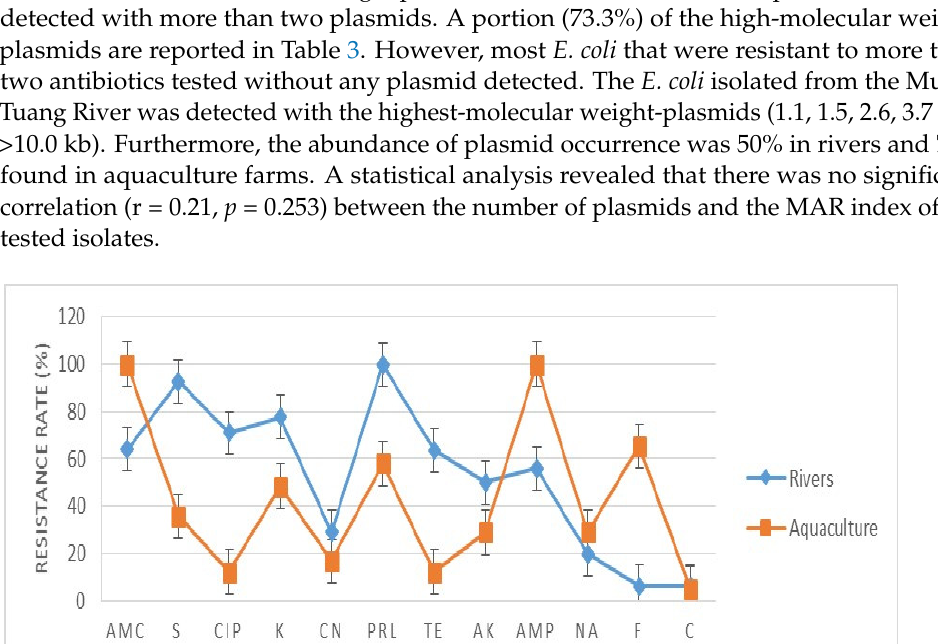
Figure 3. The percentage (%) of Escherichia coli isolated from aquaculture farms that showed Sus- ceptible, Intermediate and Resistant against the 12 antibiotics tested.